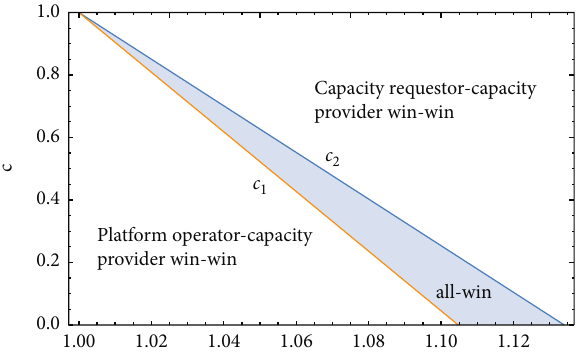
Figure 9: Win-win situation.